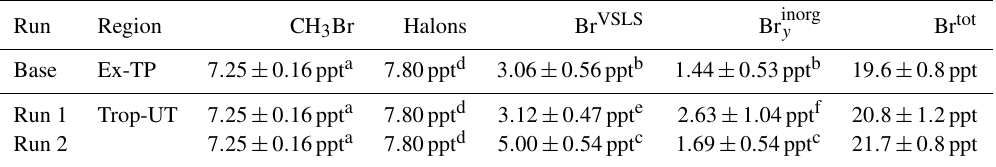
Table 3. Bromine boundary conditions near the TP from various research studies for the Ex-TP and the tropical UT (Trop-UT) used to initialize the TOMCAT/SLIMCAT model. The base run uses the Ex-TP bromine boundary conditions along the entire TP for all latitudes. There are two further runs with elevated TP bromine initializations in the tropics (30 ◦ S–30 ◦ N, run 1 and run 2), while the extratropics are still set to the Ex-TP bromine boundary conditions as in the base